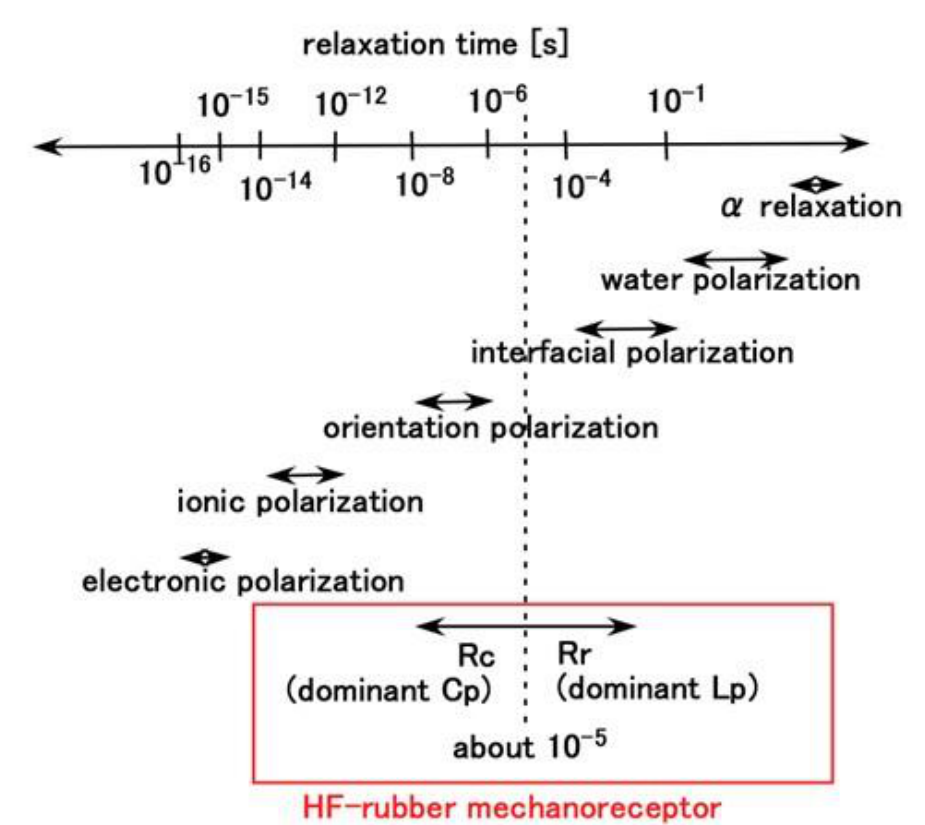
Figure A2. Schematic of the categories of polarization relaxation time of a dielectric material.